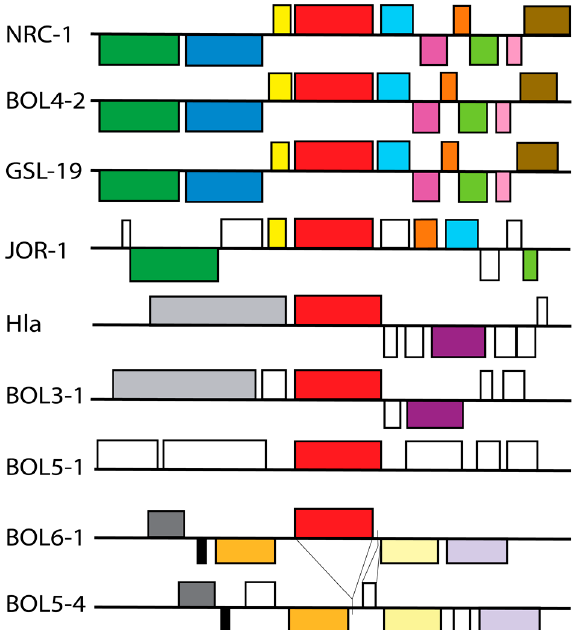
Figure 4. Gene organization around the phr 2 gene in NRC ‐ 1, BOL4 ‐ 2, GSL ‐ 19, JOR ‐ 1, Hla, BOL3 ‐ 1, BOL5 ‐ 1, and BOL6 ‐ 1 and corresponding region in BOL5 ‐ 4. Genes are color ‐ coded with the direction of transcription indicated by placement above (rightward) or below (leftward) thick back lines. The long ‐ chain fatty acid ‐ CoA ligase genes are shown in dark green, sulfatase ‐ like hydrolase/transferase genes in dark blue, thioesterase genes in dark yellow, phr 2 genes red, sod 2 genes in light blue, genes corresponding to a hypothetical protein in magenta, DUF5827 family protein genes in dark orange, MBL fold metallo ‐ hydrolase genes in light green, cupin domain ‐ containing protein genes in pink, FAD ‐ dependent thymidylate synthase genes in brown, DEAD/DEAH box helicase genes in light gray, GHMP kinase genes in purple, DUF115 domain ‐ containing protein genes in dark gray, FGF80_09825 ‐ like hypothetical genes in black, cell division protein genes in light orange, sugar phosphate isomerase/epimerase genes in light yellow, Gfo/Idh/MocA family oxidoreductase genes in light purple, and other non ‐ homologous genes in white. The deletion and insertion of DNA in the phr 2 gene region of BOL5 ‐ 4 are indicated by lines between the BOL5 ‐ 4 and BOL6 ‐ 1 maps.